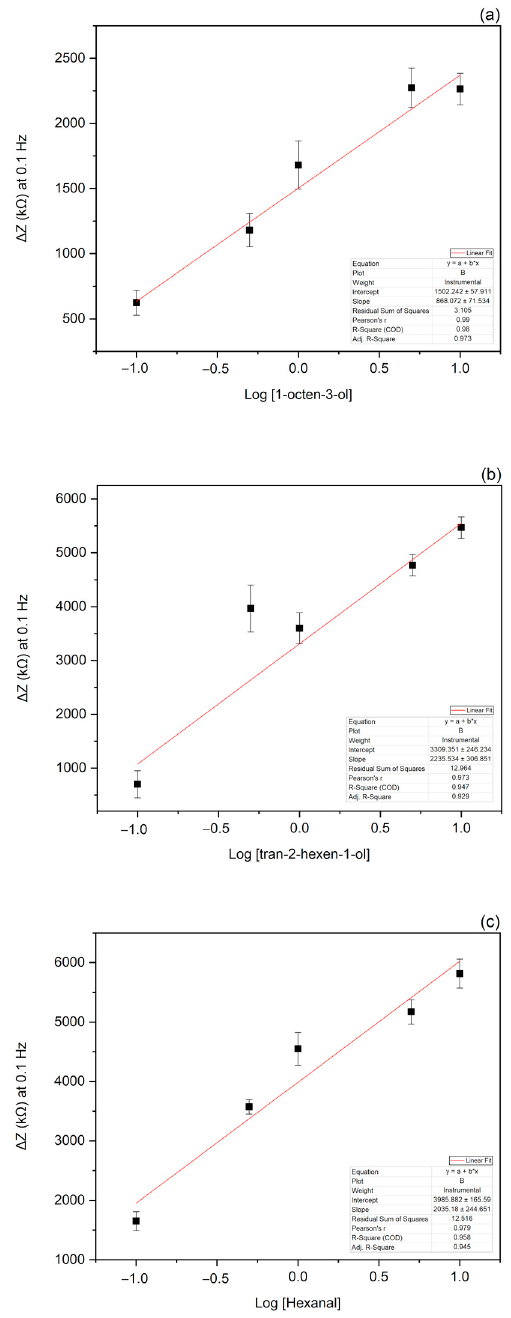
Figure 6. Calibration curves of 1-octen-3-ol, trans-2-hexen-1-ol, and hexanal. The fitting curves were obtained by plotting the logarithmic value of 1-octen-3-ol ( a ), trans-2-hexen-1-ol ( b ), and hexanal ( c ) concentrations versus the change of the impedance value at 0.1 Hz.